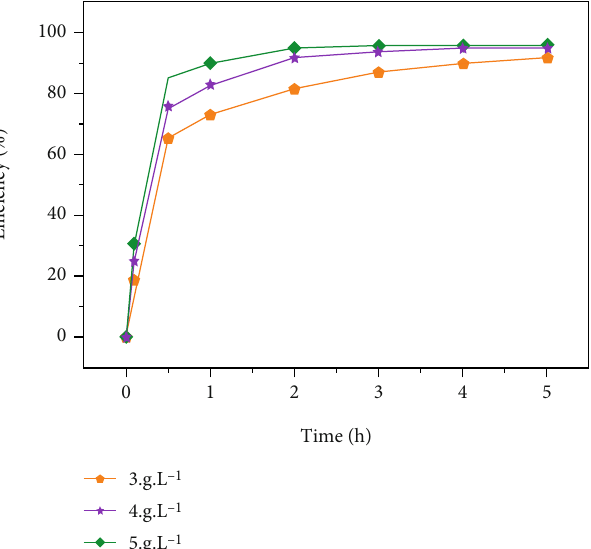
Figure 13: Evaluation of the e ff ect of biochar 1 dosage on